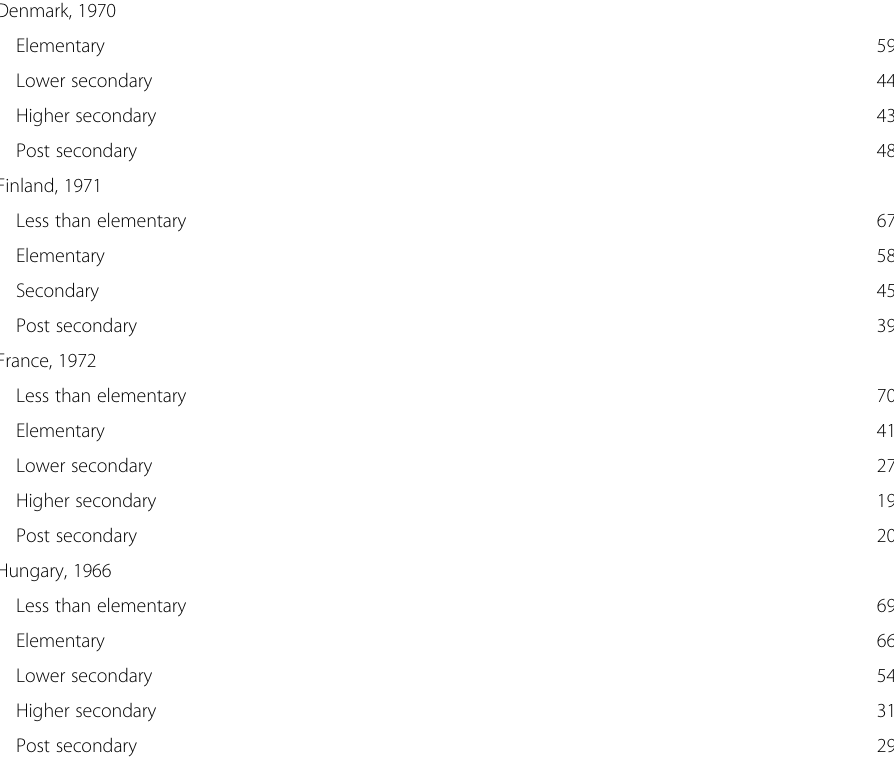
Table 15 Percent of women who did not know how many children they wanted at time of marriage, according to